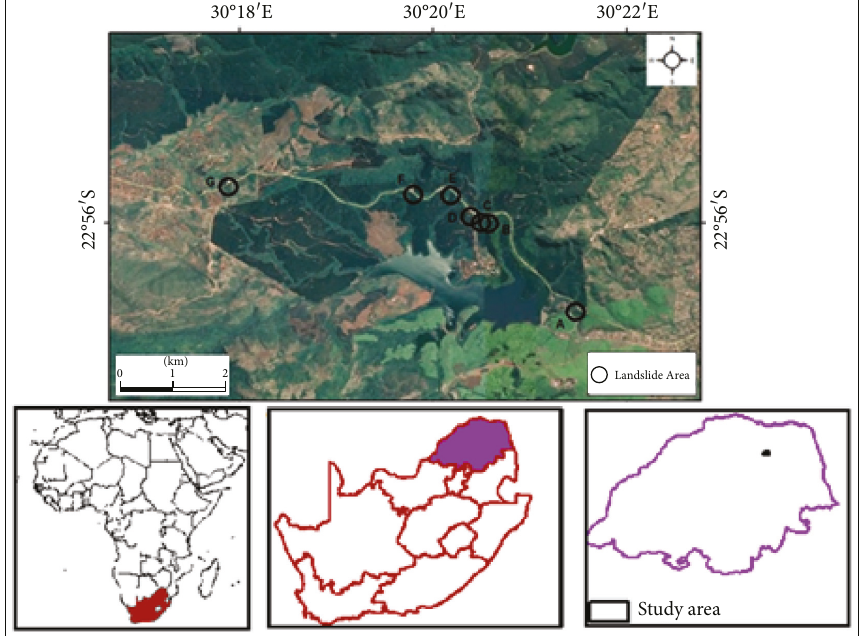
Figure 1: Locality map of the study